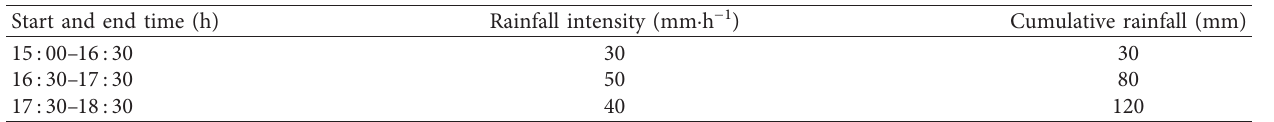
Table 4: Rainfall condition